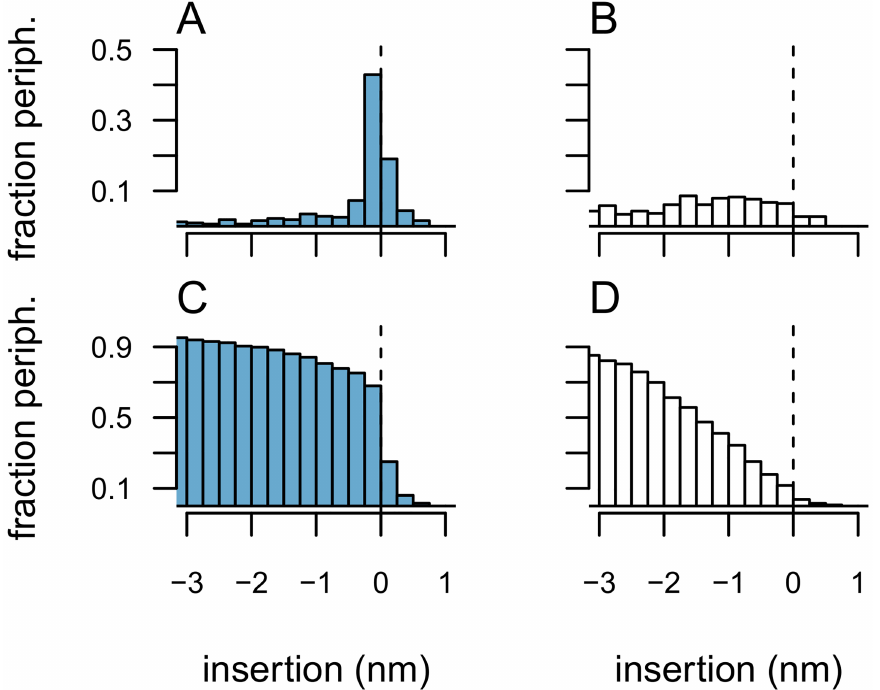
Fig 8. Comparing predictions based on protruding hydrophobes with the predicted IBS in the Orientation of Proteins in Membranes (OPM) database. The plots show the distributions of the median ‘insertion coordinate’ from OPM for ‘the Likely Inserted Hydrophobe’ in each family (measured at the C α -atom, ‘Peripheral’ dataset). Values greater than or equal to zero correspond to atoms positioned in the hydrophobic core or at the boundary. Hence insertion coordinate values close to zero indicate agreement with OPM. Panels A and C show data for the Likely Inserted Hydrophobes and panels B and D for a null model of randomly selected ‘protruding’ residues. Panels C and D show cumulative histograms (accumulated with decreasing insertion